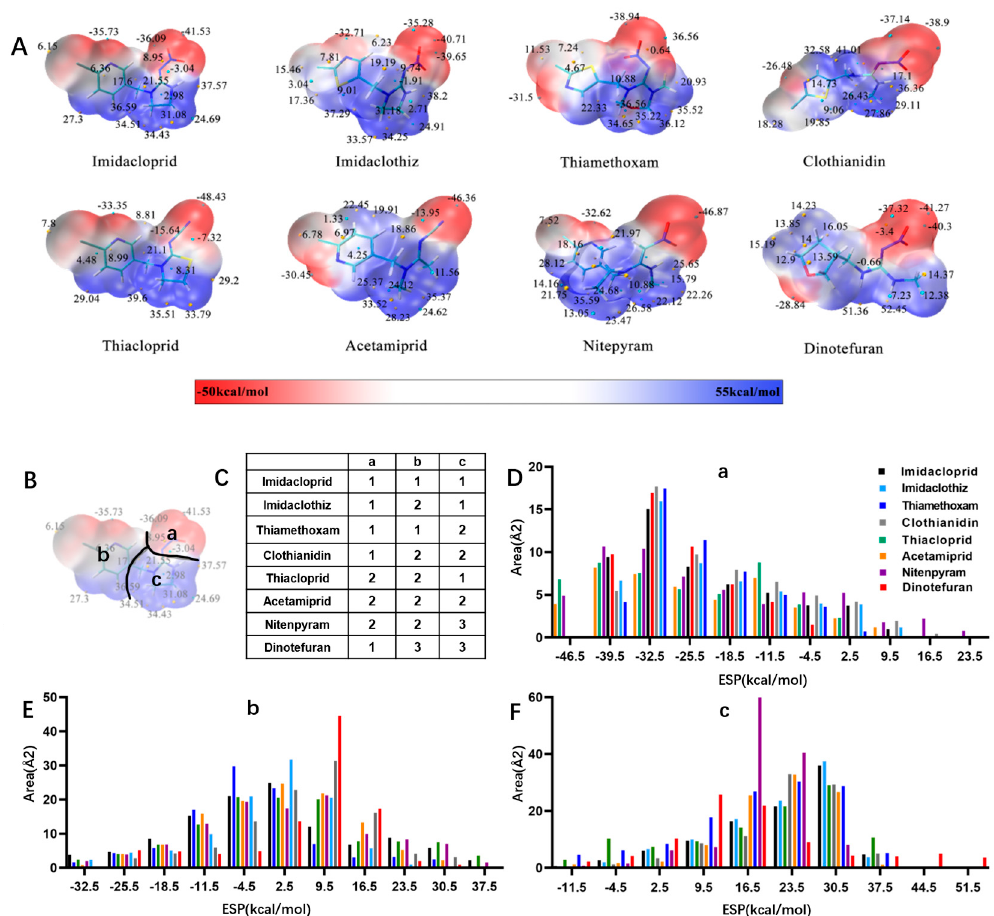
Figure 2. ESP analysis of 8 neonicotinoid pesticides. ( A ) ESP distribution on the surface of 8 neonicotinoid pesticides. The cyan and yellow balls are the minimum and maximum values mapped to the molecular surface. ( B ) Compound region division based on ESP characteristics. ( C ) Similarity of each region, indicated by Types 1, 2 and 3. ( D − F ) Surface area in each ESP range of three regions (a, b, and c).